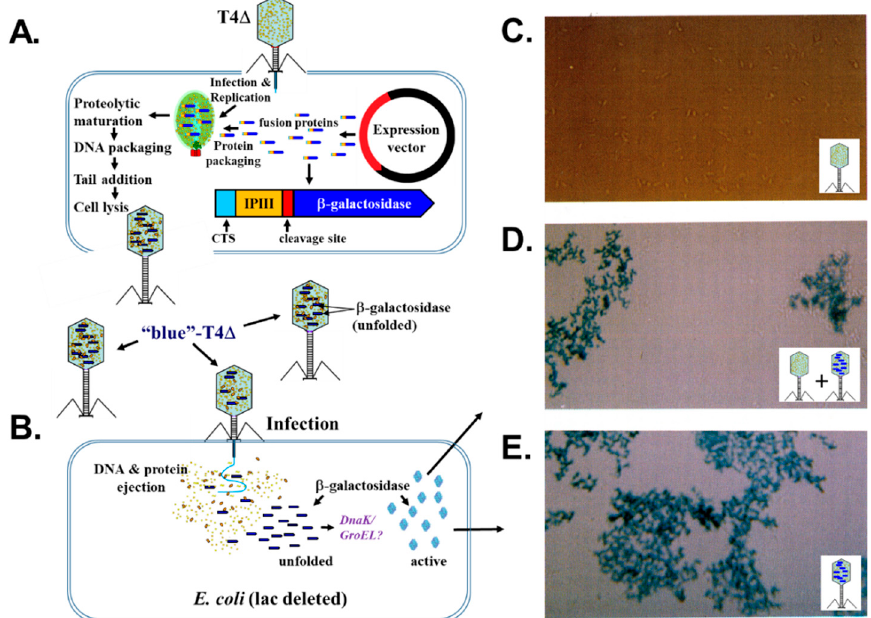
Figure 4. Delivery of β -galactosidase into E. coli via the T4 expression-packaging-processing system. ( A ) Scheme of the incorporation of β -galactosidase produced by an expression plasmid into the T4 head via its fusion to the T4 internal protein IPIII and ( B ) subsequent infection of the progeny “blue”-T4 Δ phage and ejection of β -galactosidase into an infected cell. The T4 Δ genotype is Δ e- Δ IPIII- Δ IPII-alt − s12 [32,52]. Light microscopy of E. coli cells infected with ( C ) T4 Δ , ( D ) T4 Δ and “blue”-T4 Δ and ( E ) “blue”-T4 Δ after incubation with X-Gal. (B–E) adapted from Hong and Black (1993).